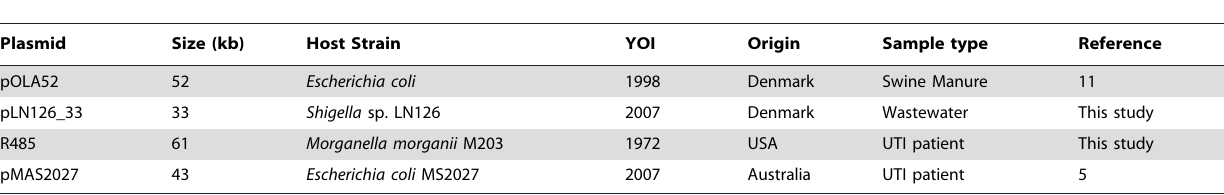
Table 1. Reported occurrences of type 3 biofilm promoting IncX-plasmids.